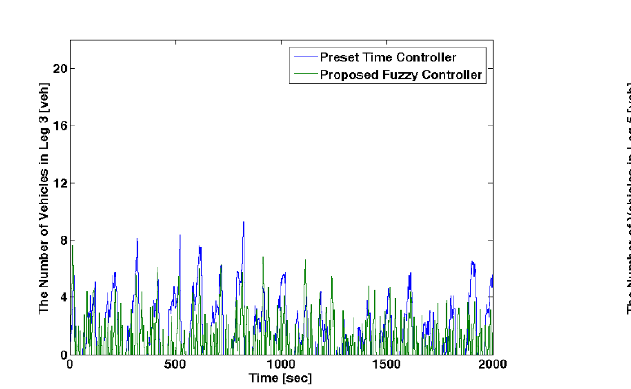
Figure 13. The number of vehicles in Leg3